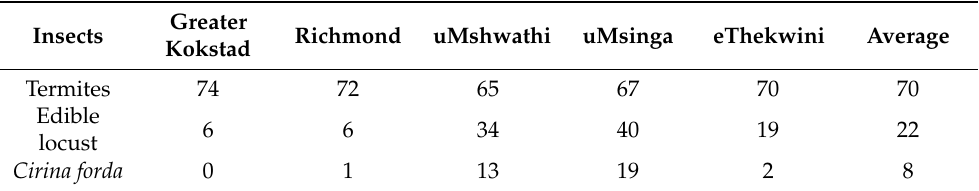
Table 5. Percentage of respondents that consumed insects across five municipalities in KZN, South